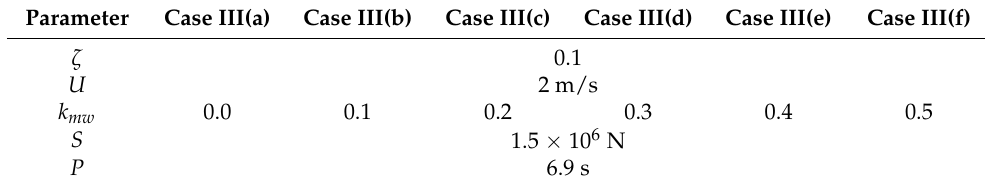
Table 4. Detailed parameters of different